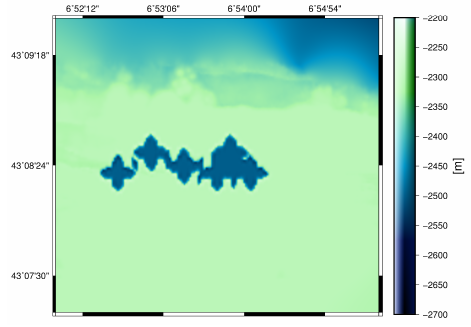
Figure 5: View of mineralogic block top surface.